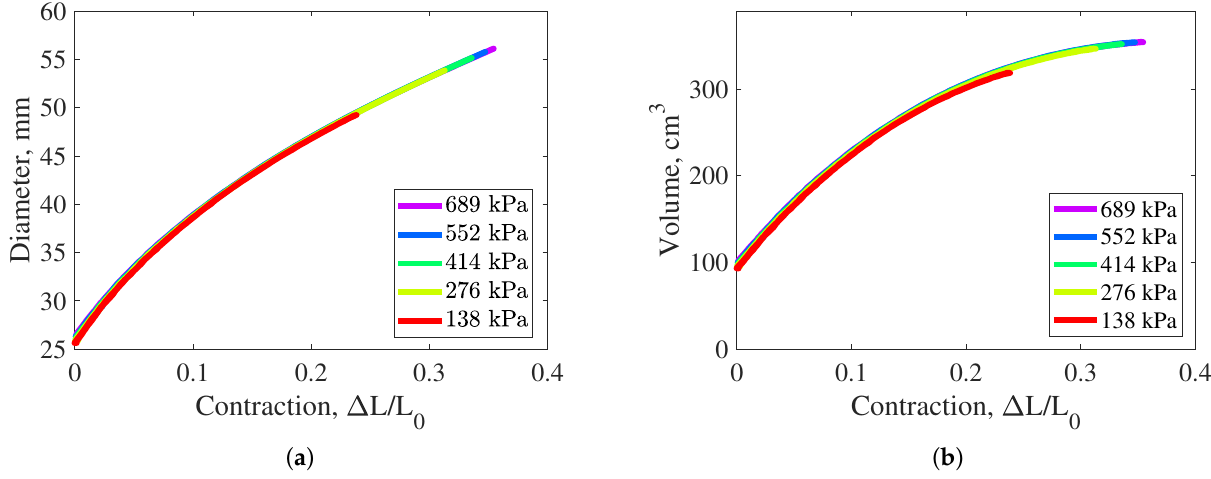
Figure 15. Initial analysis of the measured profiles for the full contraction ranges of 139–689kPa (20–100psi) tests: ( a ) Average diameter. ( b ) Internal air